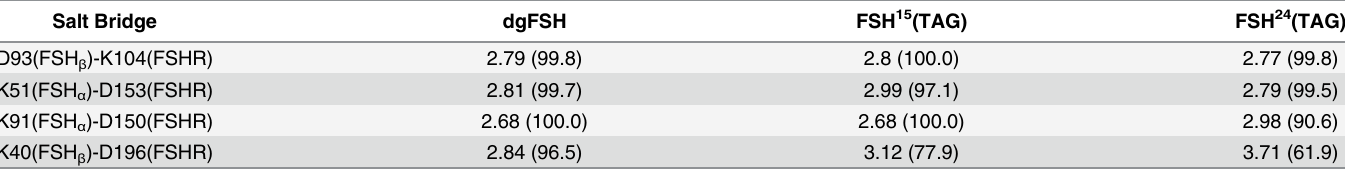
Table 2. Median O-N distances for selected inter-protein salt bridges. Values are in Angstroms, averaged of molecular dynamics conformational sam- pling. Parenthetical values represent the fraction of time in which the O-N distance is less than 3.5 Å . Salt